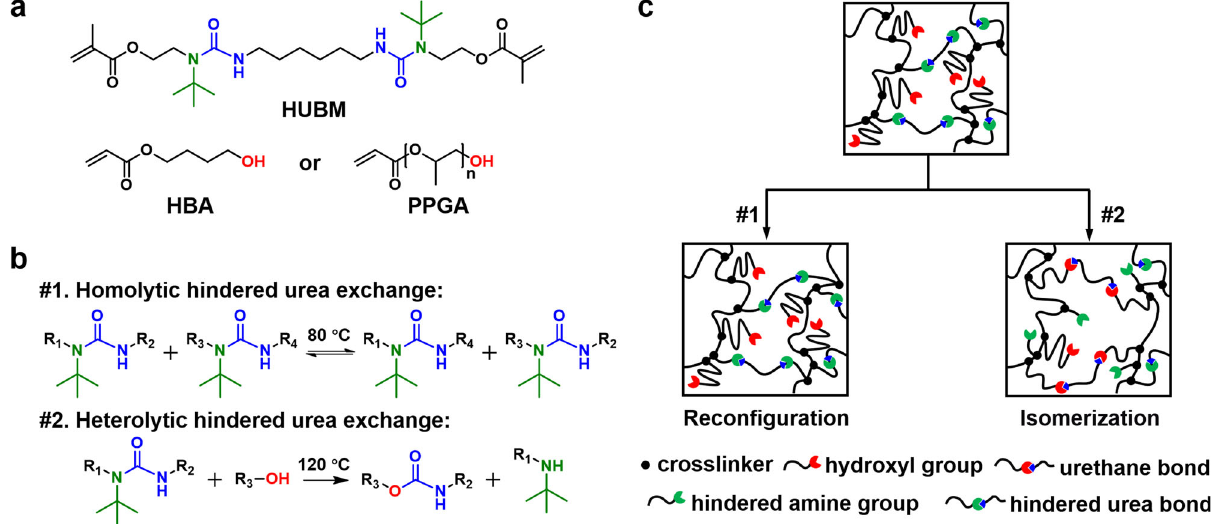
Fig. 1 | Moleculardesignofthe3Dprintabledynamicnetwork. a Monomer precursors. b The homolyticand heterolyticexchange reactions atdifferent temperatures. c Schematic illustration of two distinct network rearrangement